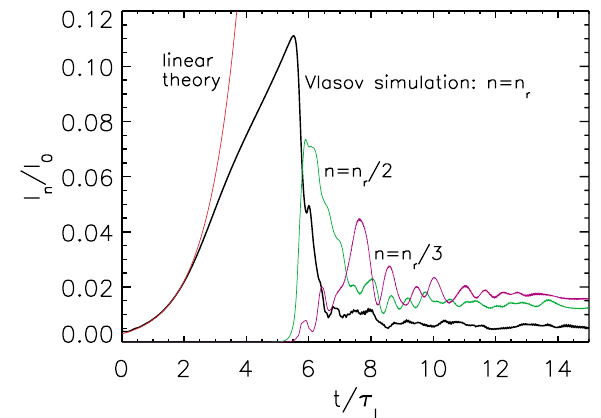
FIG. 8. (Color) Time evolution of the current amplitudes ob- tained from the Vlasov simulation for U sc (cid:2) 10 , V bb (cid:2) 0.1 , and n r (cid:2) 24 .